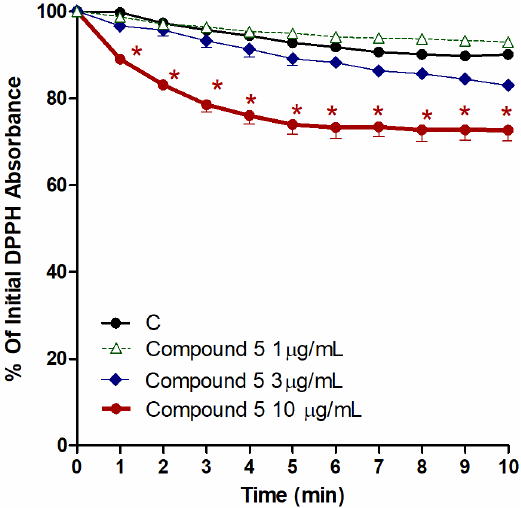
Figure 7. Influence of the CHCl 3 fraction and isolated metabolite 5 on the production of ROS, as inducted by 240 µM DPPH. Control (C) is a reaction mixture with DPPH only. Results are displayed as mean ± SEM ( n = 3). * p < 0.05 when compared to each corresponding control.